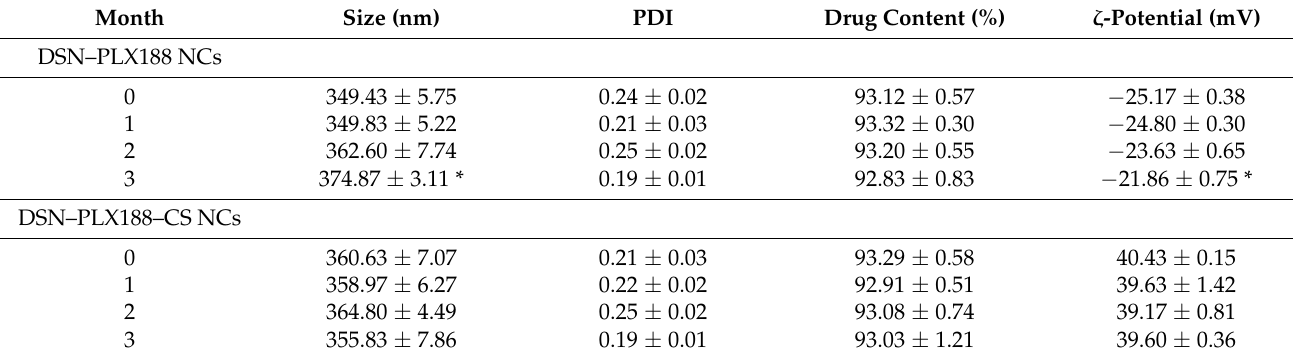
Table 5. Storage stability of the selected lyophilized NCs at room